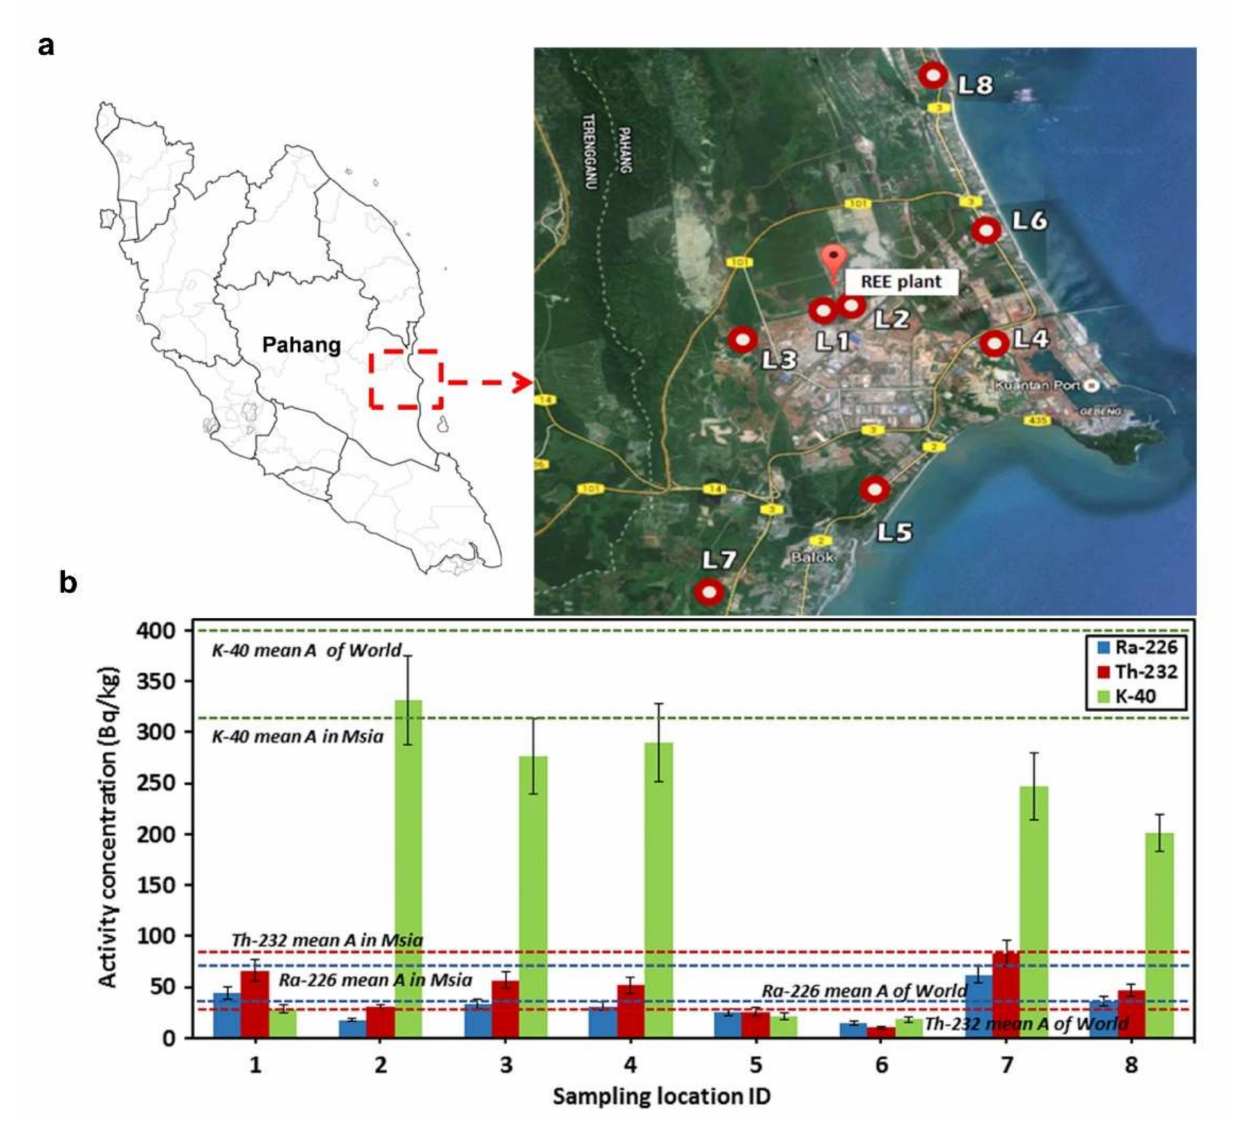
Figure 10. Environment monitoring by silica fiber-based thermoluminescence dosimetry. ( a ) Sam- pling locations off-site of the rare-earths processing facility, Pahang, Malaysia. ( b ) Activity con- centration of elements recorded by the Ge-doped collapsed photonic crystal fiber. Reprinted with permissions from ref. [121]. Copyright 2017, IOP Publishing